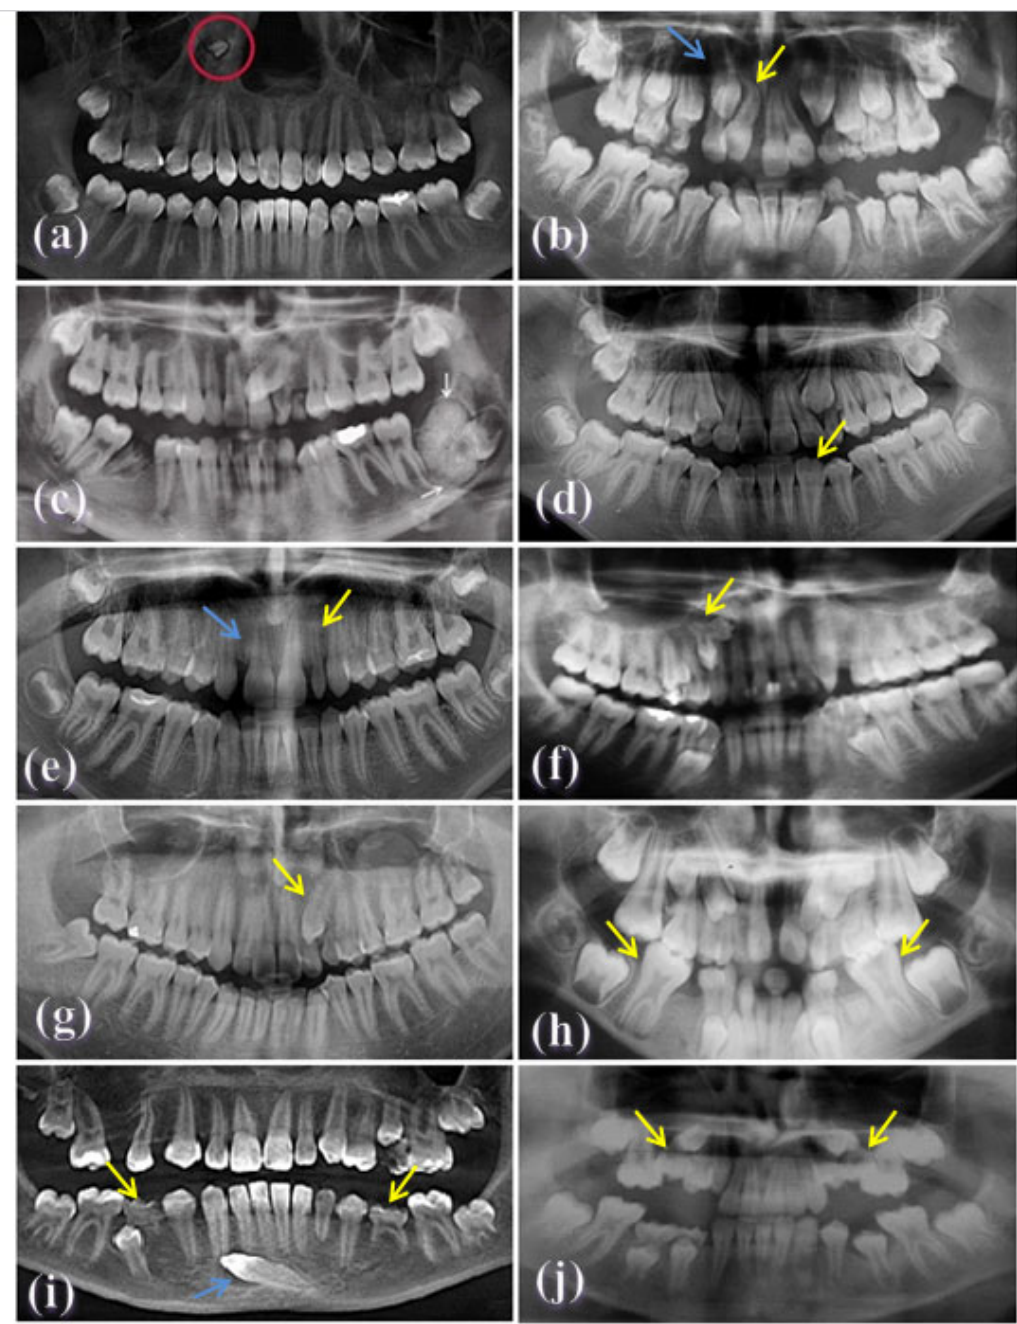
Figure 2. Examples of dental anomalies evaluated on panoramic radiographs: ( a ) an ectopic super ‐ numerary tooth located at the right maxillary sinus (red circle) (a 16 year ‐ old patient); ( b ) dilacera ‐ tion of tooth #11 (yellow arrow), and transposition of the maxillary lateral incisor and canine (blue arrow) (a 12 ‐ year ‐ old patient); ( c ) compound odontoma at the left angle of the mandible (white ar ‐ rows) (a 21 ‐ year ‐ old patient); ( d ) fusion of teeth #31 and #32 (yellow arrow) (a 14 ‐ year ‐ old patient); ( e ) an example of missing teeth #12 (blue arrow), and a peg shaped toot #12 (yellow arrow) (a 16 ‐ year ‐ old patient); ( f ) gemination (yellow arrow) (a 25 ‐ year ‐ old patient); ( g ) an impacted upper ca ‐ nine #23 (yellow arrow) (a 24 ‐ year ‐ old patient); ( h ) taurodontia of lower first molars (yellow arrows) (a 7 ‐ year ‐ old patient); ( i ) transmigration of the lower canine (blue arrow) and retained teeth #75 and #85 (yellow arrows) (a 13 ‐ year ‐ old patient); and ( j ) subemerged primary upper second molars (yel ‐ low arrows) (a 9 ‐ year ‐ old patient).